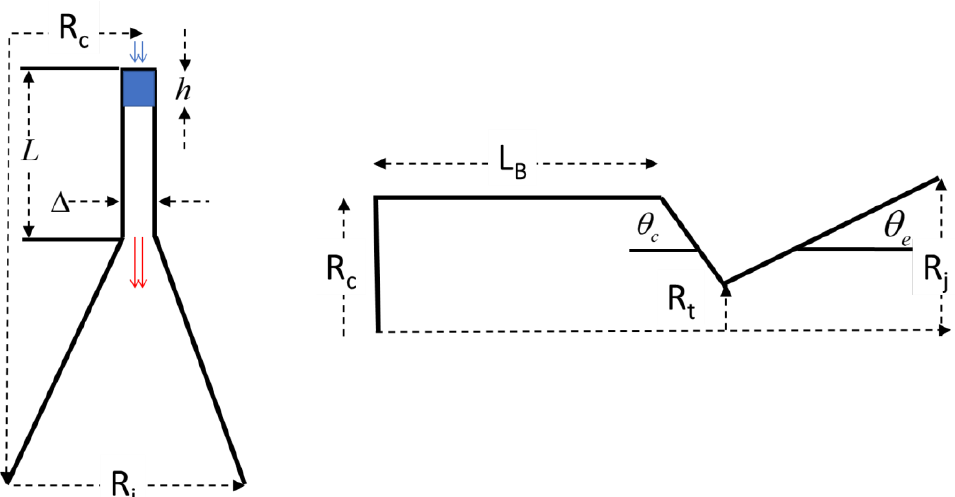
Figure 5. (l) RDRE thrust chamber design assumed for the study (r) Companion CP combustor geometry .